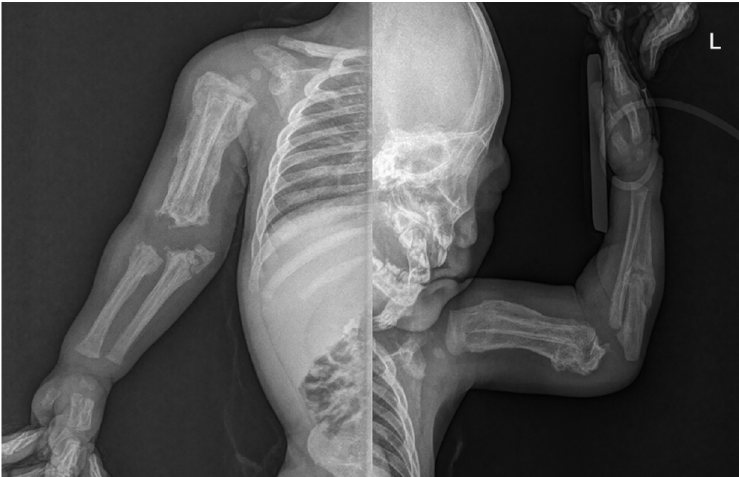
Figure 3. Radiograph of upper limb showing hyperostosis with fractures of both ulna.